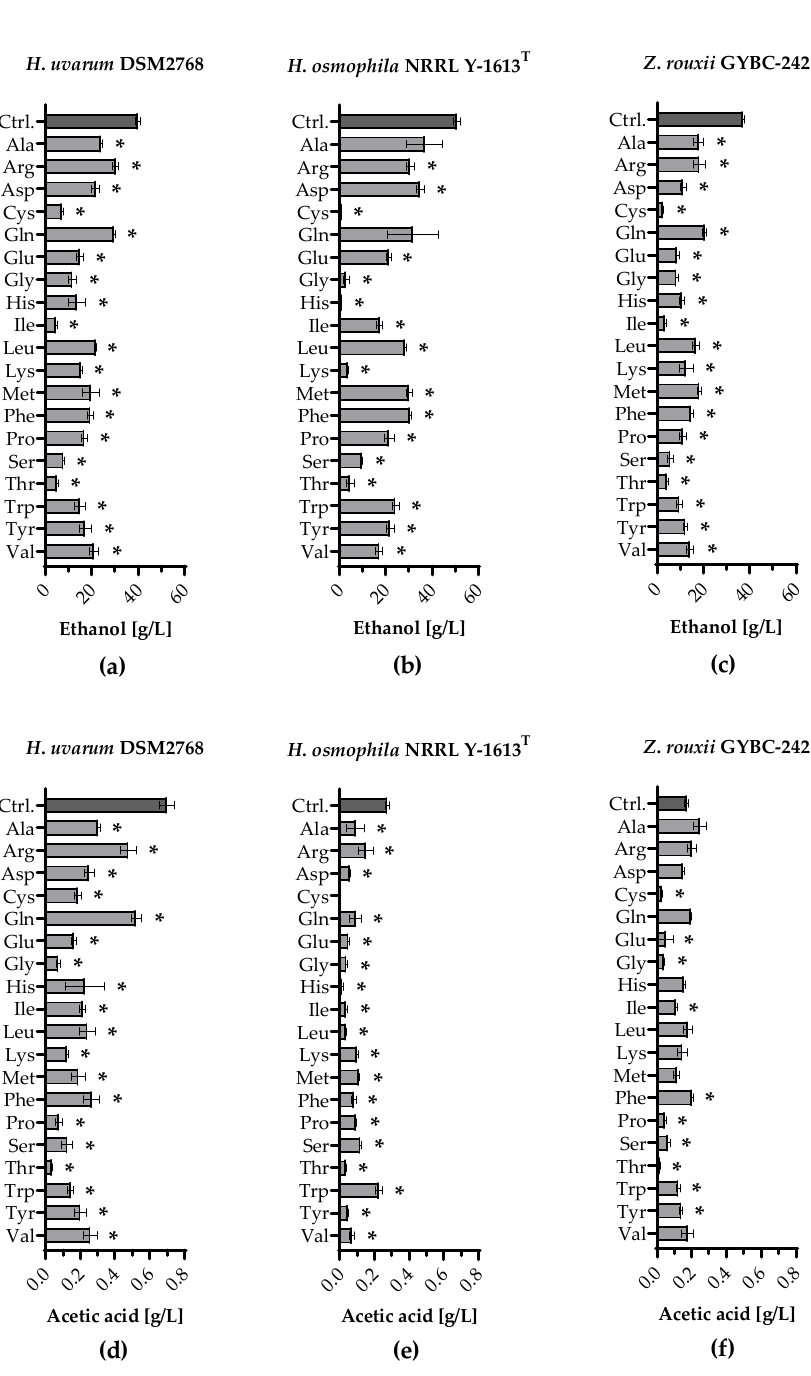
Figure 4. Ethanol production and formation of acetic acid during fermentation with individually supplemented amino acids. Ethanol production [g/L] in fermentations using ( a ) H. uvarum DSM2768, ( b ) H. osmophila NRRL Y-1613 T and ( c ) Z. rouxii GYBC-242. Formation of acetic acid [g/L] in fermentations using ( d ) H. uvarum DSM2768, ( e ) H. osmophila NRRL Y-1613 T and ( f ) Z. rouxii GYBC-242. Fermentations using the respective yeast with SM-mix served as control (Ctrl.). Ethanol and acetic acid concentrations were measured via high performance liquid chromatography (HPLC) analysis. Data are the mean of three independent experiments ± SEM, two-tailed unpaired t test with Welch’s correction, * p < 0.05 as compared to the control. Error bars indicate the standard deviation. Ethyl acetate, 2-phenylethyl acetate and isoamyl acetate are among the most aroma- relevant acetate esters produced during wine fermentation. In Figure 5a it can be seen that